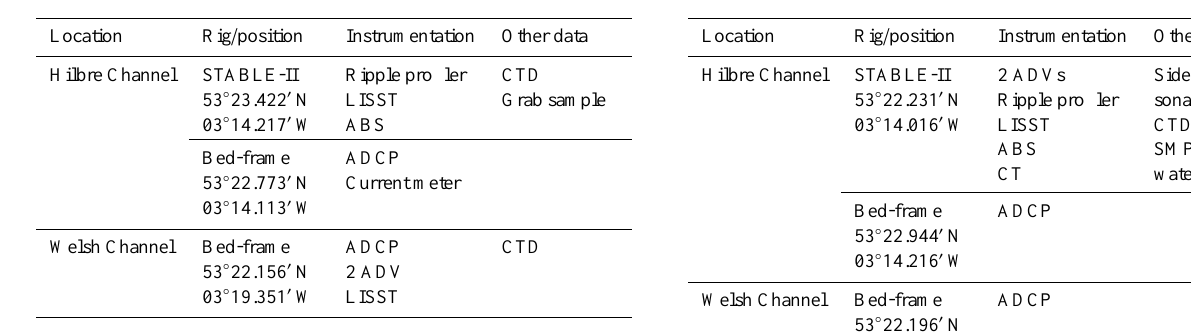
Table 5. Summary of the February 2006 data.